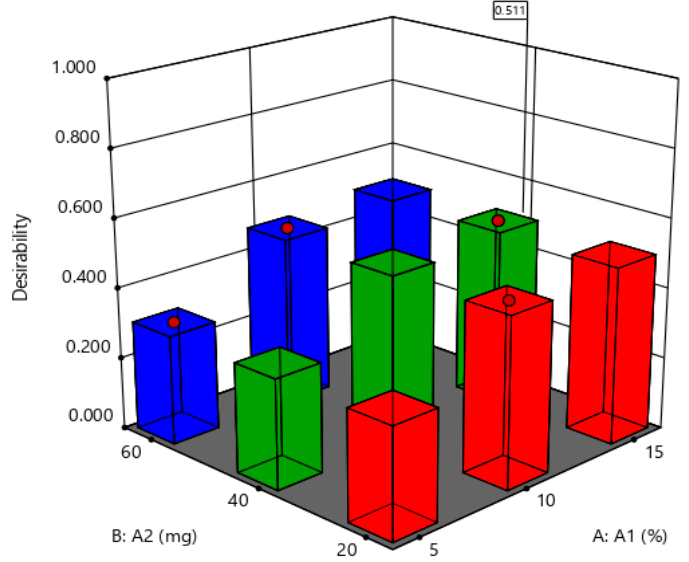
Figure 5. Three-dimensional surface plot of desirability for the optimized SLN formulation design.